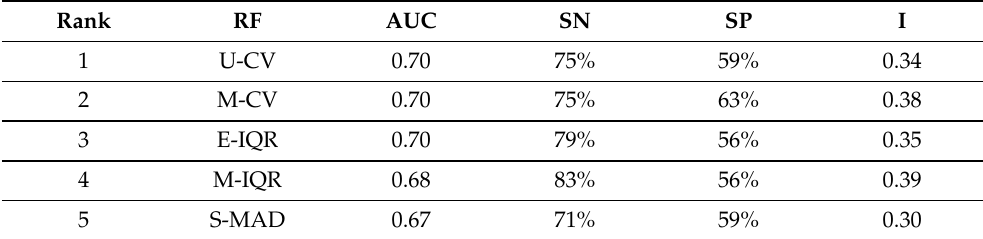
Table 4. Performance of the RFs finally selected in the PET/CT discrimination